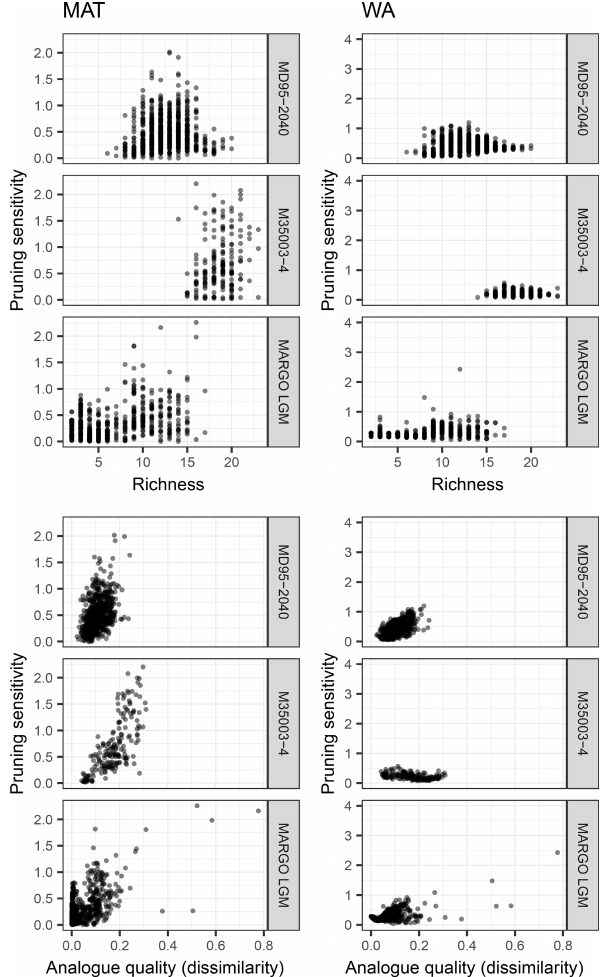
Figure 7. Exploring the effect of species richness and analogue quality on the sensitivity to species pruning. This sensitivity is de- fined as the standard deviation of the reconstructions with more than the minimum required number of species (i.e. based on trans- fer function models with uninformative species, which are those to the right of the red dot in Fig. 4). Analogue quality is defined as the average dissimilarity from the five most similar samples in the training set; zero values thus mean perfect analogues. A clear effect of richness cannot be observed, yet for some of the downcore re- constructions (MD95-2040 and M35003-4) poor analogues appear associated with higher pruning sensitivity, particularly for